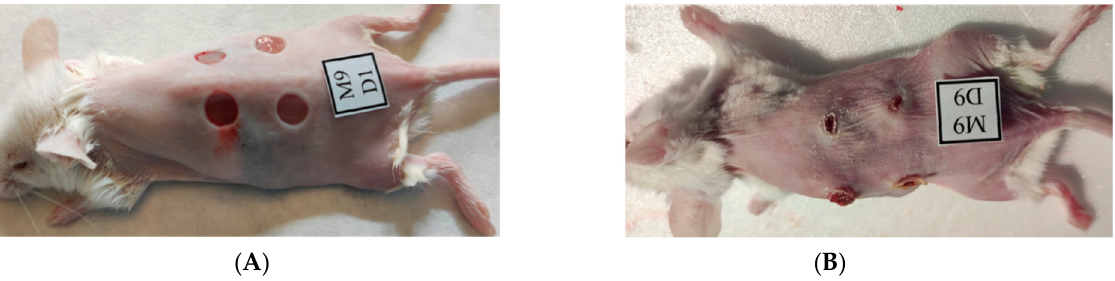
Figure 2. Digital imaging of the wound areas before ( A ) and after ( B ) treatment at D1 and D9, re- spectively.